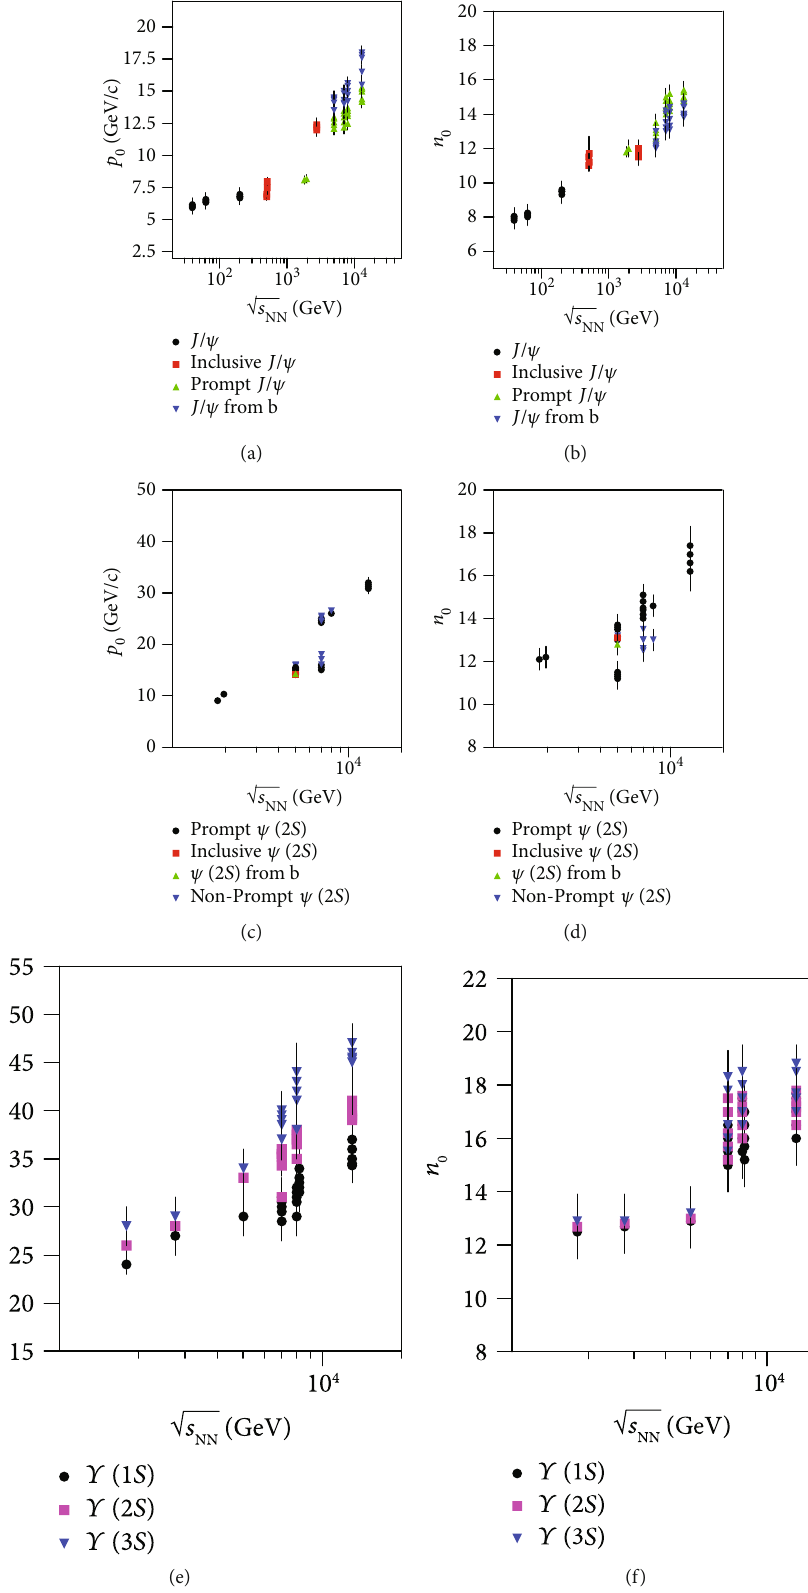
ffiffi p ffiffiffiffiffiffiffi p s n s (or ) for (a, b) J / ψ , (c, d) ψ ð 2 S Þ , and 0 on NN